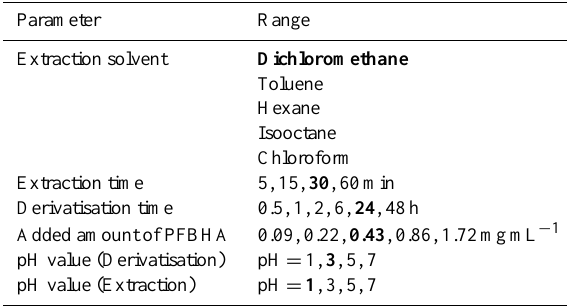
Table 2. Overview about the investigated